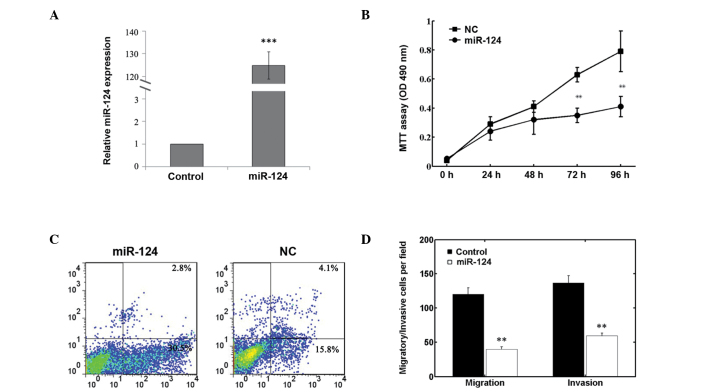
Effects of miR-124 mimics transfection on cell proliferation, apoptosis, invasion, and migration of MG63 cells. (A) The expression level of miR-124 in miR-124 mimics transfected cells was significantly higher compared with NC transfected cells. qRT-PCR was done to detect the expression of miR-124. U6 RNA was used as an internal control; (B) Cell proliferation was measured by MTT assays in MG63 cells transfected with miR-124 mimics or negative control. Data represent the mean ± SD of the experiments performed in triplicate; (C) Apoptosis of MG63 cells was detected by flow cytometric analysis after transfection with miR-124 mimics or negative control; (D) miR-124 suppressed MG63 cell invasion and migration in vitro. The Matrigel invasion and migration assays showed that the number of invaded or migrated cells was significantly lower in the miR-124 -transfected group than in the NC-transfected group.